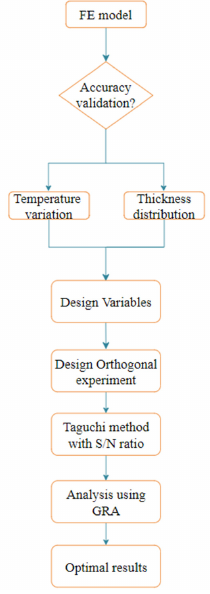
Figure 9. Flowchart of the optimal method. Firstly, the signal-to-noise ratio analysis was performed using Equation (4) and the experimental results were normalized according to Equations (6) and (7) and scaled be- tween 0 to 1. The results are shown in Table 6. Table 6. Value of Grey Relational Coefficient and Grey Relational Grade.